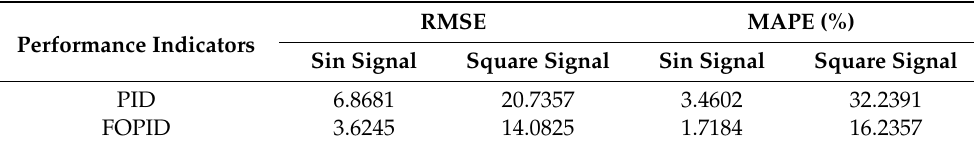
Table 5. Comparison of performance indicators between PID and FOPID. Performance